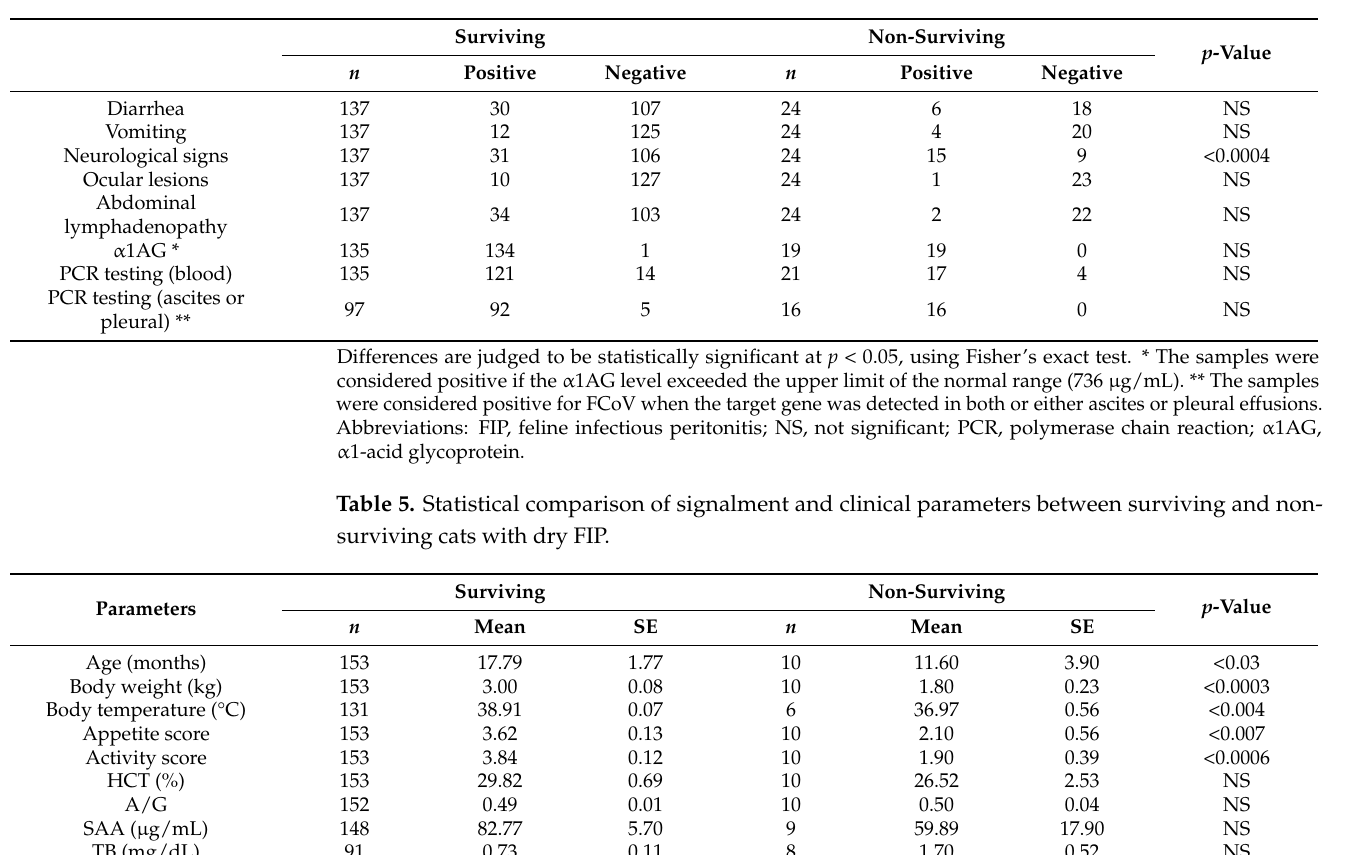
Table 4. Statistical comparison of categorical parameters between surviving and non-surviving cats with mixed FIP.